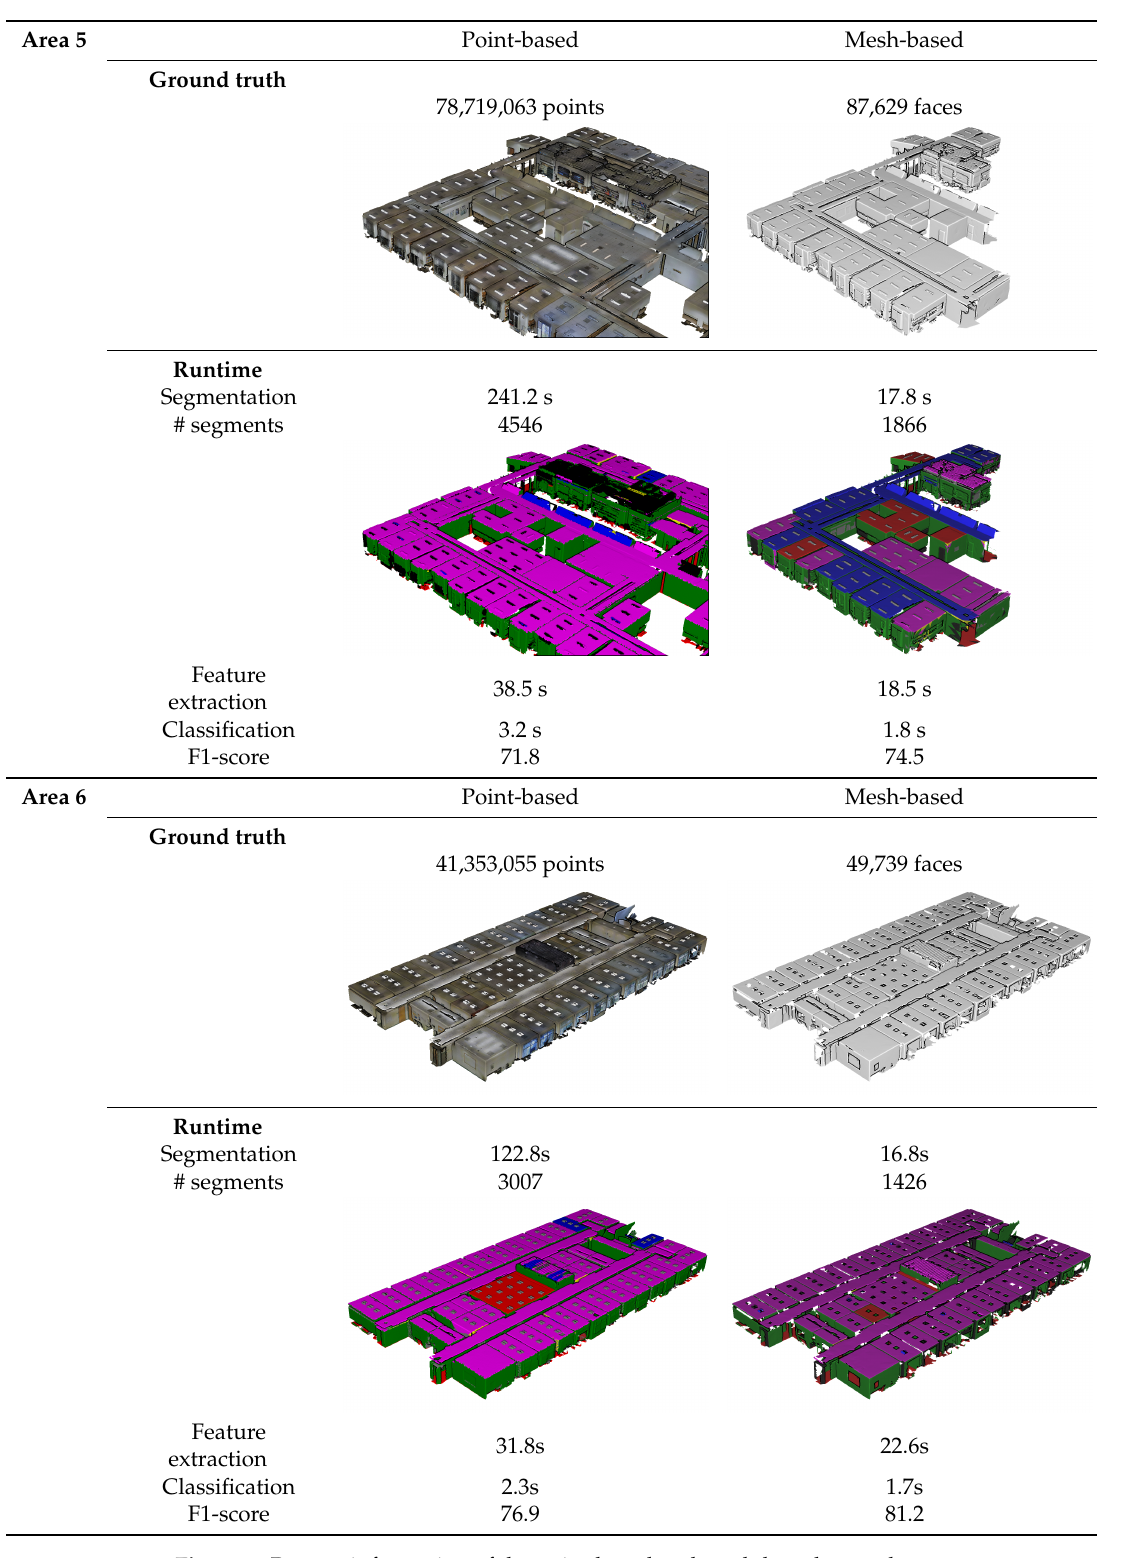
Figure 6. Process information of the point-based and mesh-based